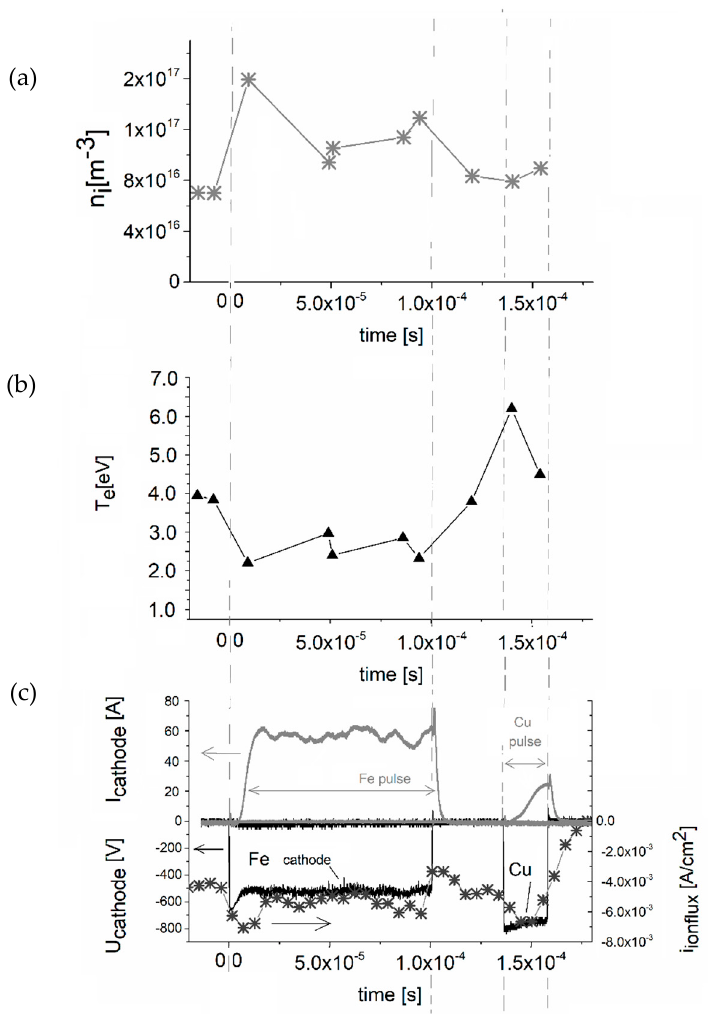
Figure 3. Time evolution of plasma parameters like ion plasma density n i ( a ), tail electron temperature T e ( b ) and ion flux density on the probe i ionflux ( c ) of reactive r-HiPIMS + ECWR plasma with applied RF power P RF = 180 W.